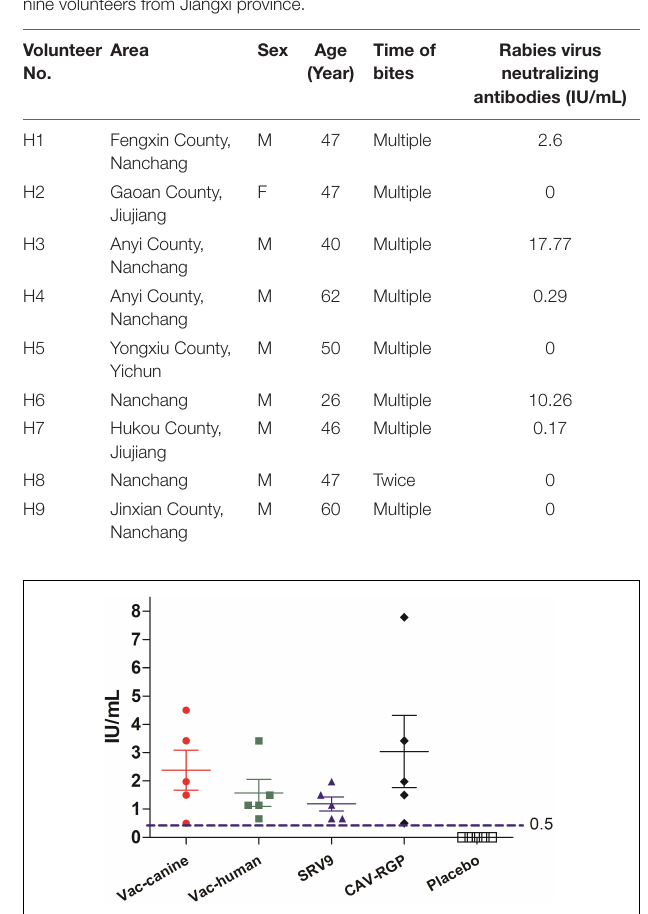
FIGURE 3 | Rabies virus neutralizing antibody (RVNA) titers after 14 days vaccination in mice.